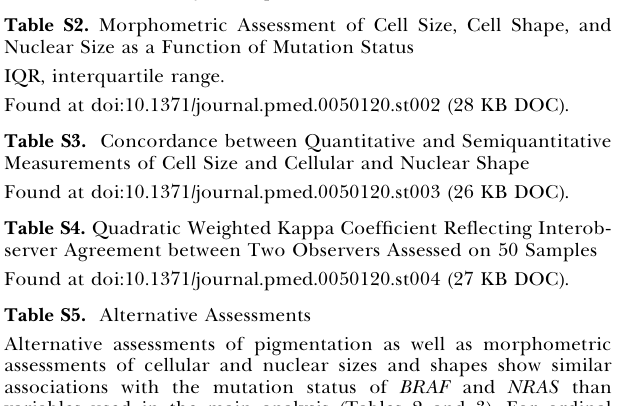
Figure S1. Grading of Morphological Features (A) Epidermal contour, (B) lateral circumscription of tumors, (C) cell size. Found at doi:10.1371/journal.pmed.0050120.sg001 (1.6 MB JPG). Table S1. Alternative Assessments of Pigmentation The data are shown by mutation status of BRAF and NRAS . The variable of maximum pigmentation was used for statistical analysis and is shown in Tables 1–3. Total percentages that do not add up to 100% have missing values. Found at doi:10.1371/journal.pmed.0050120.st001 (29 KB DOC). Table S2. Morphometric Assessment of Cell Size, Cell Shape, and Nuclear Size as a Function of Mutation Status IQR, interquartile range. Table S3. Concordance between Quantitative and Semiquantitative Measurements of Cell Size and Cellular and Nuclear Shape Table S4. Quadratic Weighted Kappa Coefficient Reflecting Interob- server Agreement between Two Observers Assessed on 50 Samples Table S5. Alternative Assessments Alternative assessments of pigmentation as well as morphometric assessments of cellular and nuclear sizes and shapes show similar associations with the mutation status of BRAF and NRAS than variables used in the main analysis (Tables 2 and 3). For ordinal variables the OR is displayed as mean OR per incremental unit. CI is confidence interval. Table